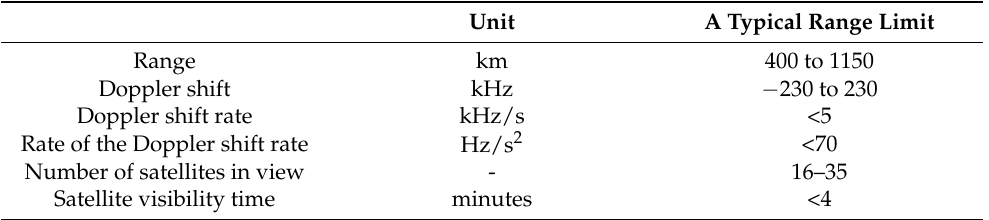
Table 1. Typical range limits of range dynamics and visibility for a static observer located at mid- latitude and using an elevation angle mask of 25 ◦ . The Doppler shift and the Doppler shift rates are given for 11,325 MHz, which is one of the Starlink signal frequencies. The used TLE file contains the orbits of nearly 3000 satellites. Unit A Typical Range Limit Range km 400 to 1150 Doppler shift kHz − 230 to 230 Doppler shift rate kHz/s Rate of the Doppler shift rate Hz/s 2 Number of satellites in view - Satellite visibility